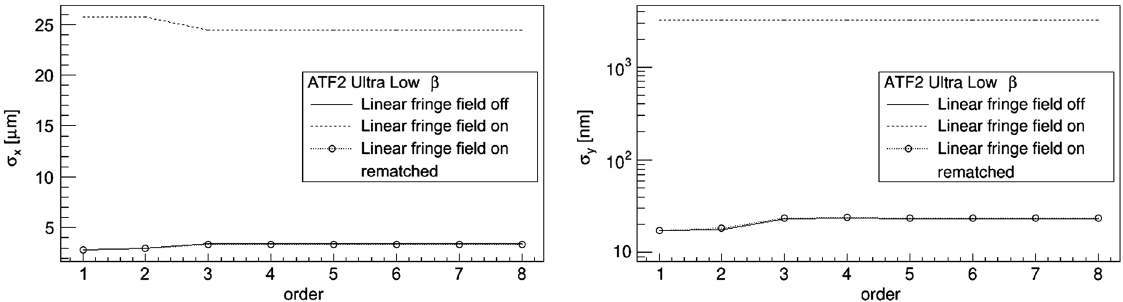
FIG. 5. Linear fringe field impact on the horizontal (left) and vertical (right) beam size in the ATF2 Ultra Low β (cid:1) lattice, together with a correction of the fringe field effect using the FD quadrupoles as reported in Table